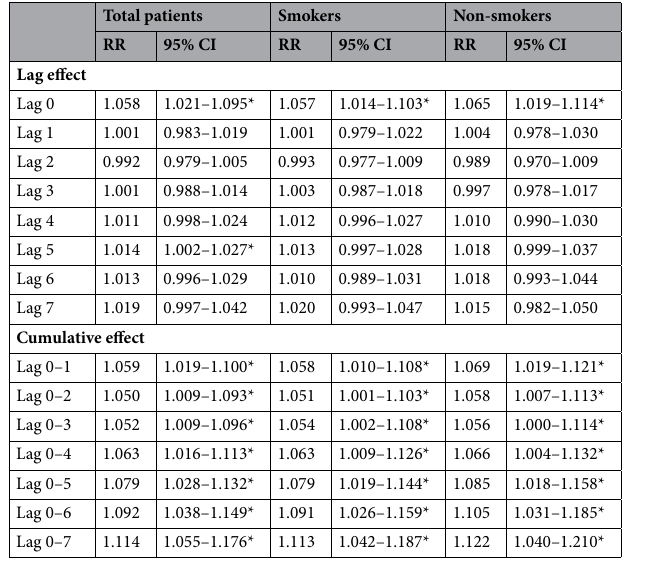
Table 3. Relative risks with 95% CI of AECOPD hospitalizations in Shijiazhuang during 2015–2018 based on 10 μg/m 3 increases in the fine particulate matter (PM 2.5 ) concentration. * p < 0.05.